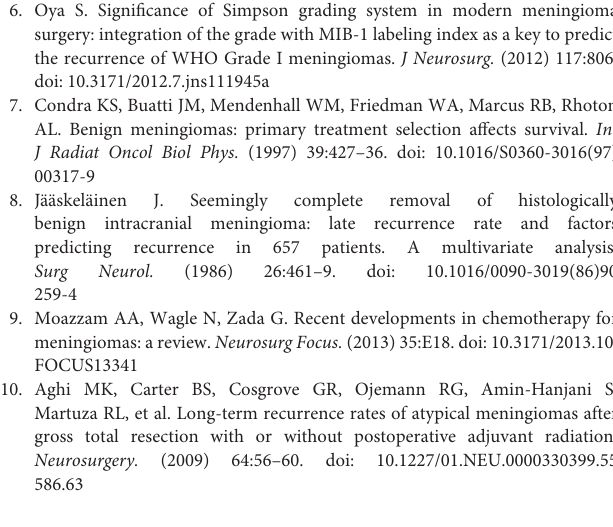
FIGURE S1 | Validating meta-genes as representations of module gene expression. (A) The proportion of variance explained by each principle component (PC) in the “tan” (left) and “royal blue” (right) modules. In both cases, the first principle component explains considerably greater variance than any higher PC. (B,C) Scatter plot of patients by first and second PCs, with colors representing batch and sex, respectively. The “tan” module is depicted on the left and the “royal blue” module on the right. Only patients with annotated sex are included in (C) . Notably, there is no clustering of batch and/or sex evident along the first (or second) PC. FIGURE S2 | Distribution of histopathologic subtypes in the microarray cohort, by individual study. Top bar represents WHO grade (green = 1, black = 2, red = 3). NOS, not otherwise specified. TABLE S1 | Differentially regulated genes between grades 1 and